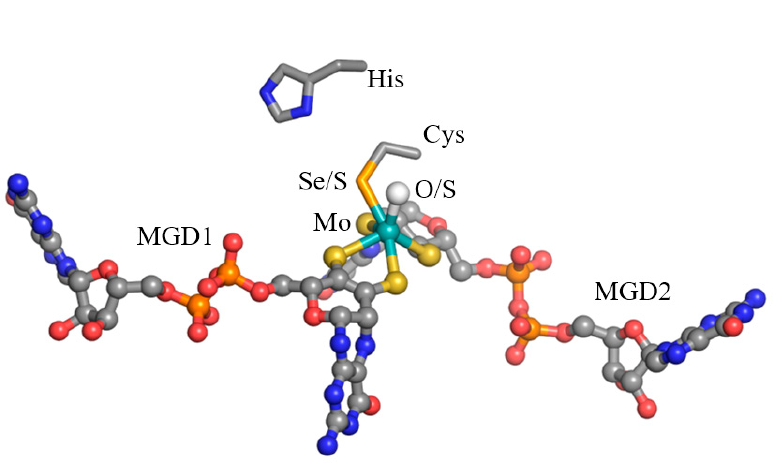
Figure 1. Oxidized form of the FDH active site from Escherichia coli (PDB 2IV2). In 1997, Boyington and coworkers first reported the crystal structure of E. coli FDH [24]. Later, in 2006, Raaijmakers and coworkers reinterpreted the crystal structure and proposed a reaction pathway of the FDH active site (Scheme 1) [25]. They suggested that SeCys is reversibly bound to the Mo center during the redox reactions so that offers a vacant